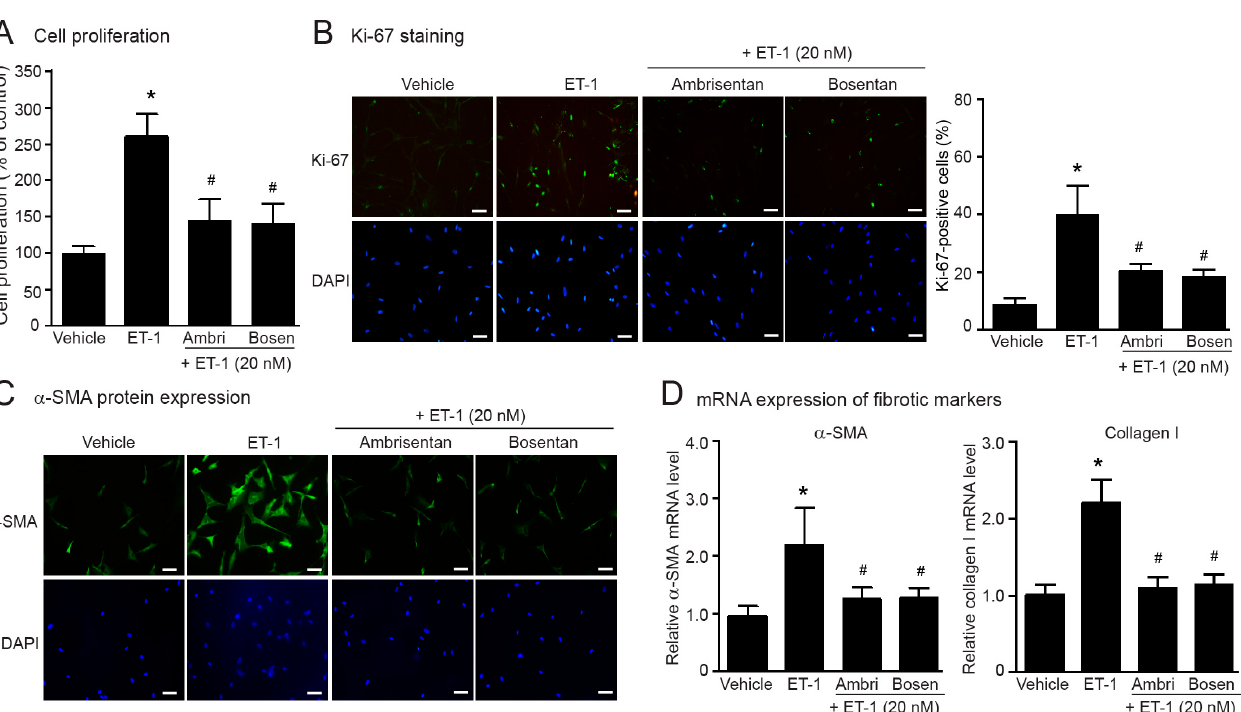
Figure 5. Preventive effects of ERAs on ET-1-induced cell proliferation and myofibroblast differentiation. Cells were pretreated without or with ambrisentan (1 µM) or bosentan (1 µM) for 1 h before treatment with 20 nM ET-1 for 24 h ( A – C ) or 12 h ( D ). ( A ) Cell proliferation was calculated as the percentage relative to the control group. ( B ) Cells were stained for Ki-67 (green) and nucleus DAPI (blue). Scale bar, 10 µm. Proliferative capacity was calculated as the percentage of Ki-67-positive cells. ( C ) α -SMA protein expression was visualized by fluorescent microscope. Cells were stained for α -SMA (green) and nucleus DAPI (blue). Scale bar, 10 µm. ( D ) Relative α -SMA and collagen I mRNA levels determined by RT-qPCR were calculated as fold over the vehicle-treated group. Data were expressed as the mean ± SD. ( n = 4). * p < 0.05 vs. vehicle; # p < 0.05 vs. ET-1.